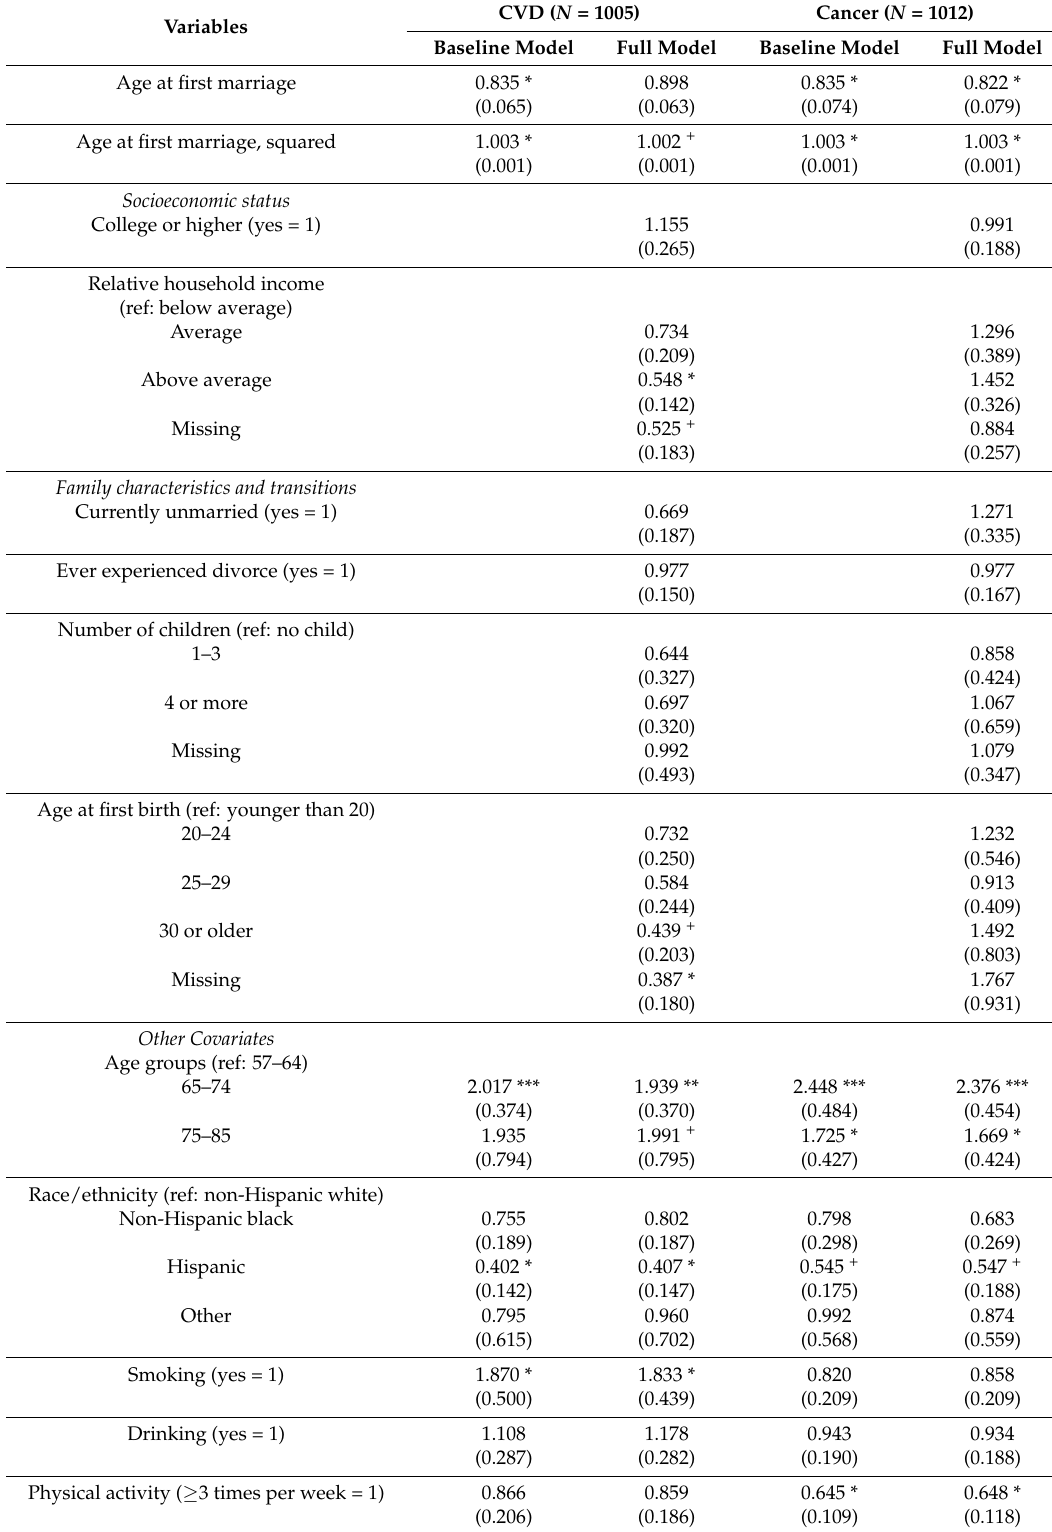
Table 2. Estimated Odds Ratios of CVD and Cancer by Age at First Marriage,